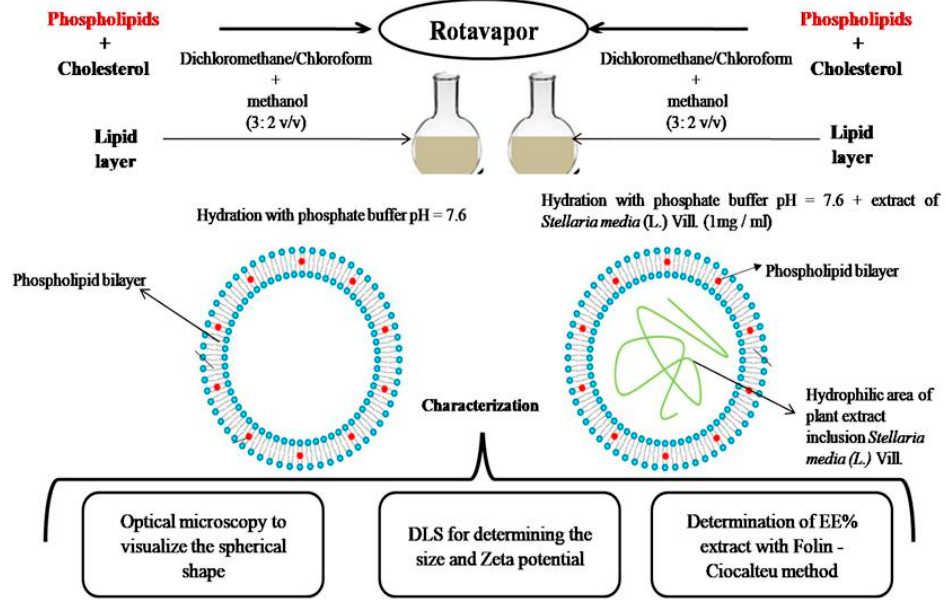
Figure 1. The preparation of the liposomes with Stellaria media (L.) Vill. extract and empty lipo- somes by lipid film hydration. by lipid film